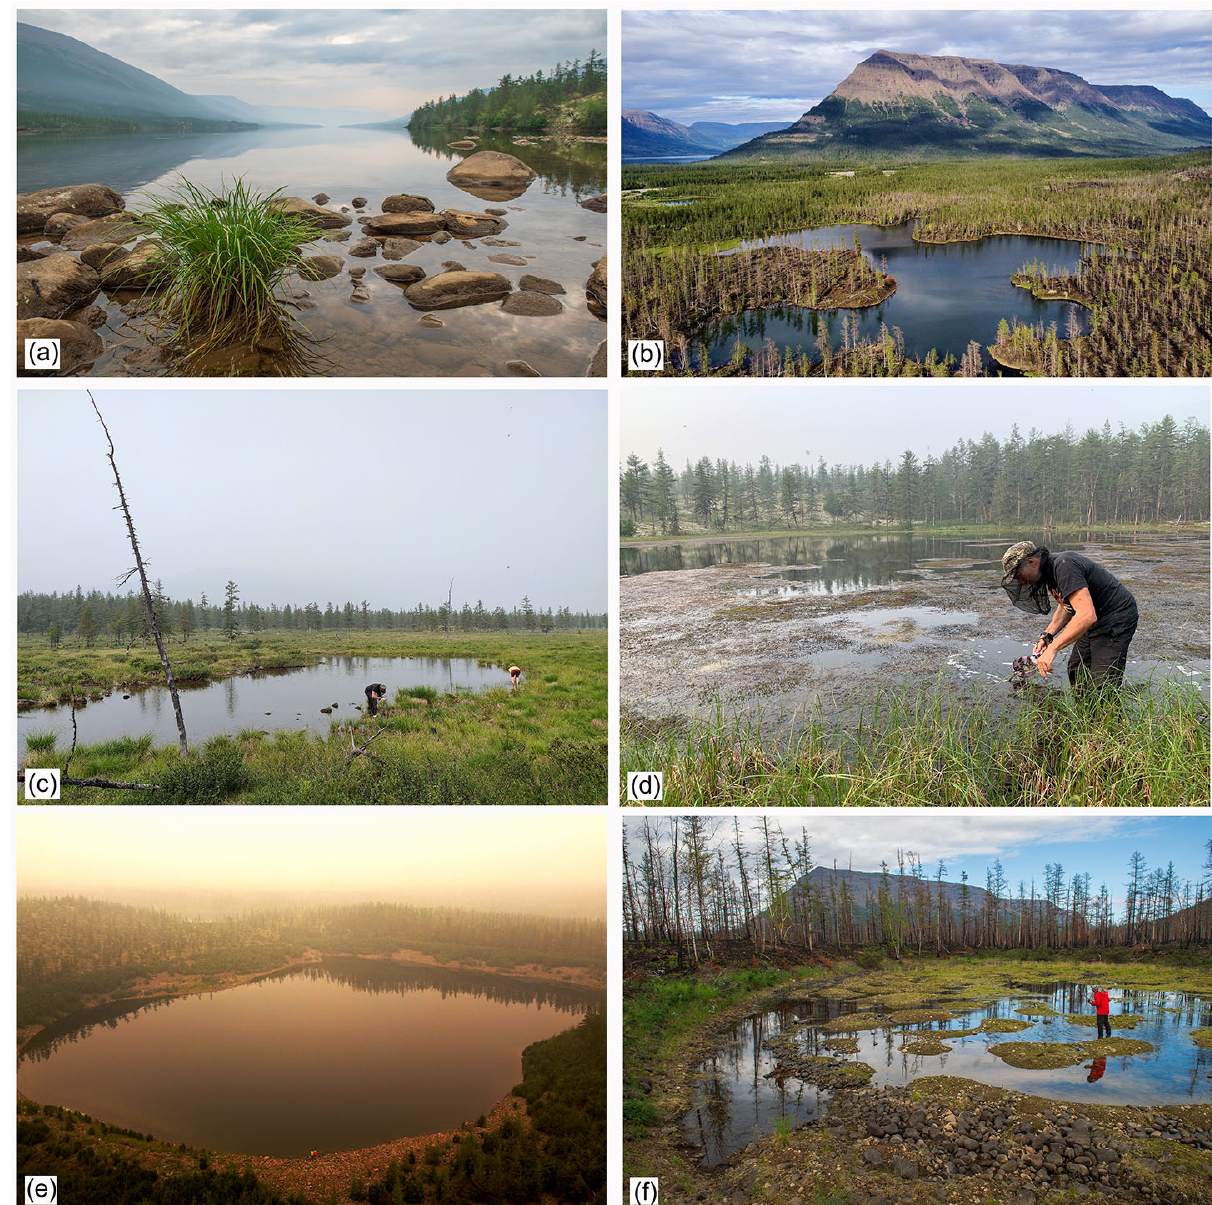
Figure 2. Main types of water bodies on Putorana Plateau: Lake Manumakly source of the Ikinda River ( a ); flowing lake on plain ( b ); oxbow ( c ); swampy lake with moss floating fen ( d ); endorheic lake in a rocky basin ( e ); drying up endorheic lake ( f ). (Photos authors: S.V. Vakorin— a , b , d , f ; I.P Sadchikov— c , e ).